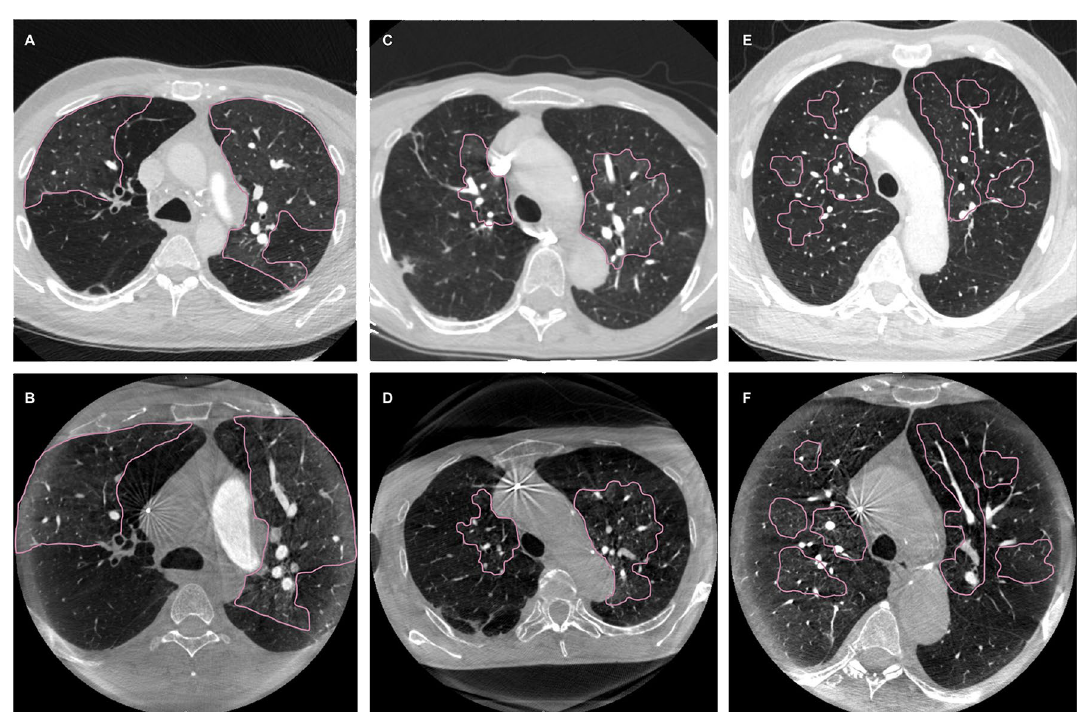
Figure 1. Patterns of mosaic perfusion on CT and CACT. ( A , B ) pattern 1, sharply demarcated segmental and/ or subsegmental areas of hypo- and hyperattenuation with well-defined borders corresponding to the anatomic unit of the secondary pulmonary lobule on CT ( A ) and CACT ( B ); ( C , D ) pattern 2, perihiliar hyperattenuating areas with peripheral perfusion defects on CT ( C ) and CACT ( D ); ( E , F ) pattern 3, diffuse heterogenity of lung attenuation with patchy low-attenuating areas located more centrally within in the secondary lobule and intermixed with areas of normal or increased attenuation on CT ( E ) and CACT ( F